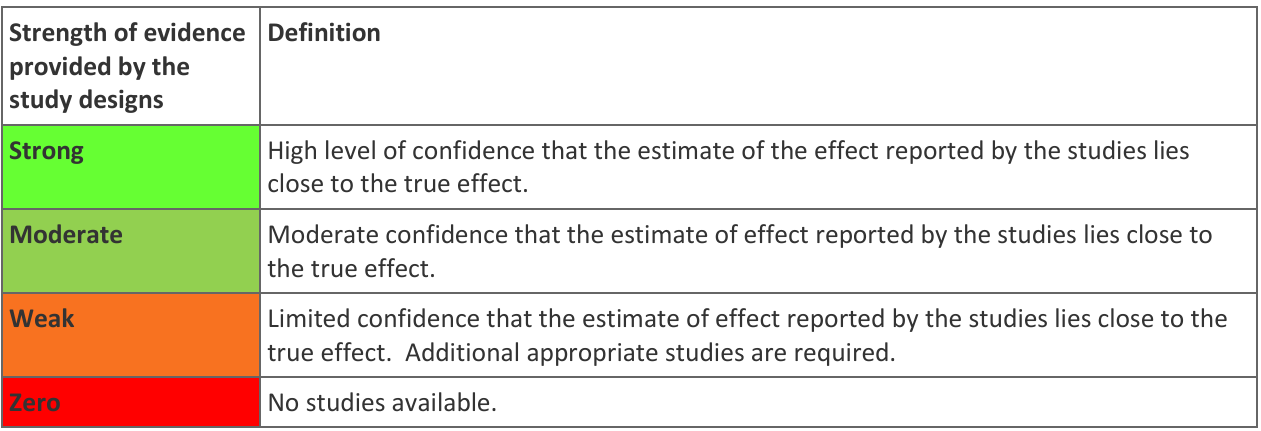
Table 2: Significance of the four levels of collective evidence used in the clinical bottom line Strength of evidence provided by